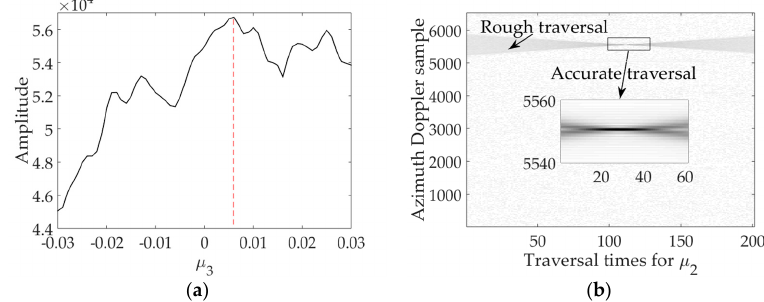
Figure 9. Simulation results for the proposed TS ‐ CFT: ( a ) traversal result for 3 μ ; and ( b ) rough and accurate traversal results for 2 μ .